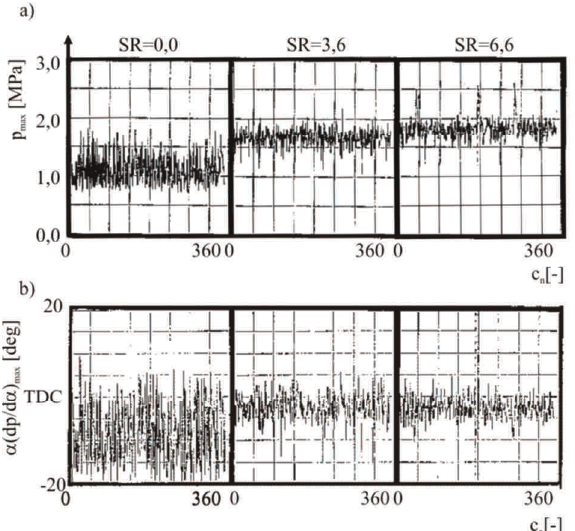
Fig. 3. The examples of impact swirl ration (SR) on [13]: a) – maximal value (p max ) of in-cylinder pressure, b) – pressure’s change (dp/d α ) by engine’s crankshaft position, α – the angle of crankshaft position, c n – engine cycle subsequent no., engine’s operation conditions: engine speed n = 1000 min –1 , engine fueled by CNG and MPI system, TWO –